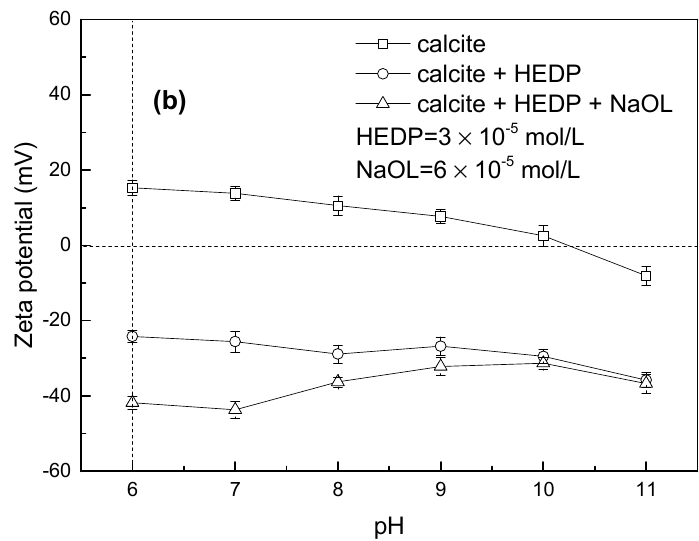
Figure 3. Zeta potentials of fluorite ( a ) and calcite ( b ) in the absence and presence of flotation reagents.